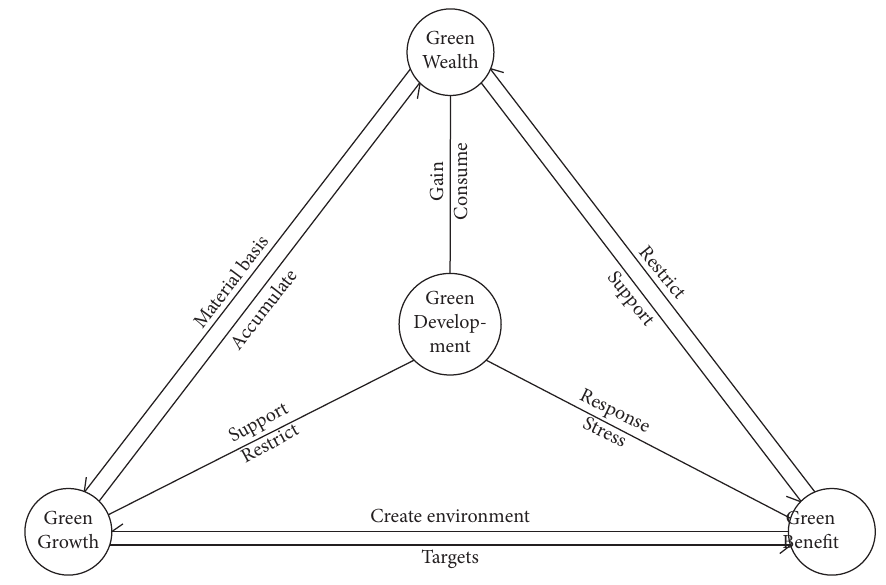
Figure 3: The green development mechanism of cities along the YRB.